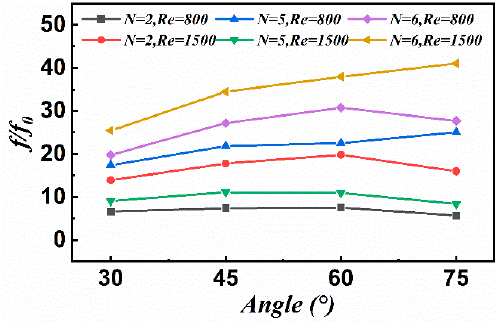
Figure 11. Variations of f/f o with deflector angle at P = 5 mm.